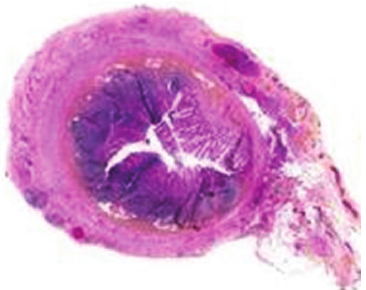
Figure 2: Histological examination of the appendix showing concretions, dense fibrinosuppurative infiltrate, and transmural granulation at the site of